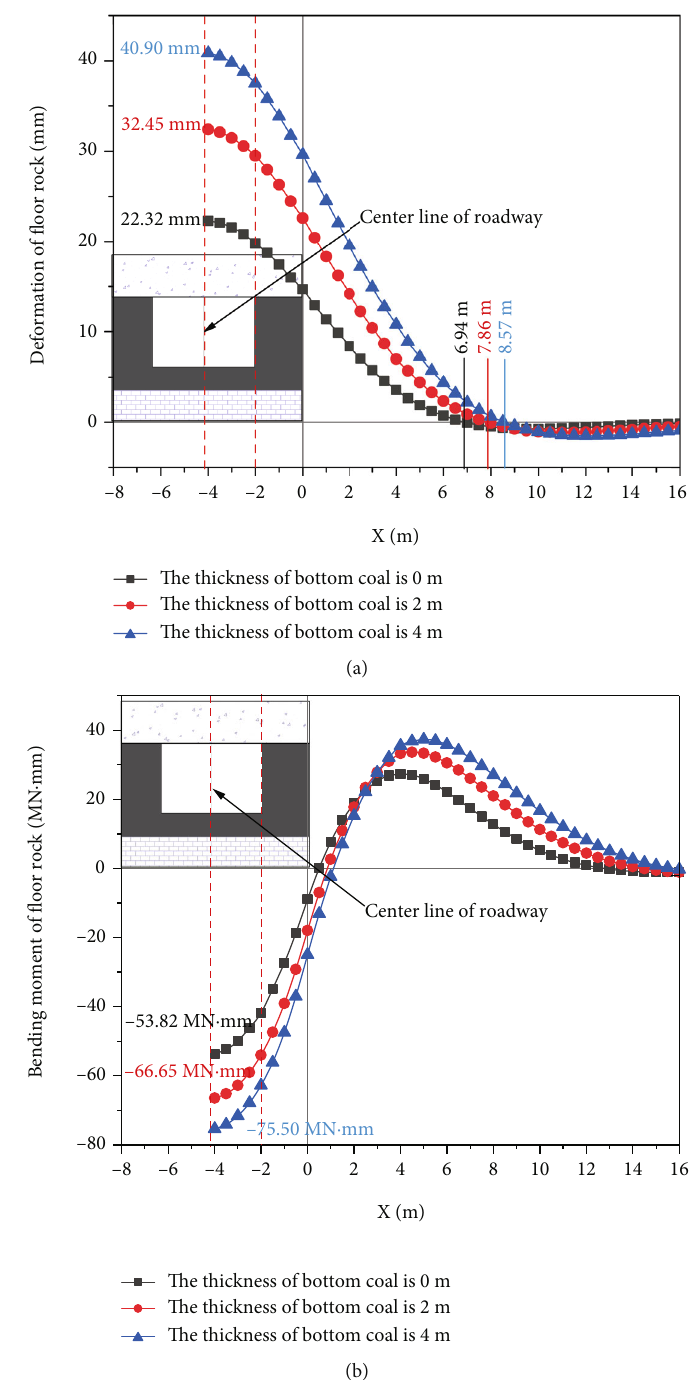
Figure 4: Deformation and bending moment of the fl oor rock under di ff erent thicknesses of the bottom coal. (a) Deformation of the fl oor rock. (b) Bending moment of the fl oor